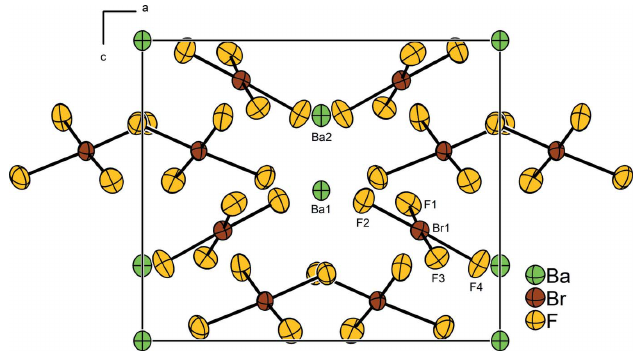
Figure 2 The crystal structure of Ba[BrF 4 ] 2 in a projection along the b axis. Displacement ellipsoids are shown at the 50% probability level.